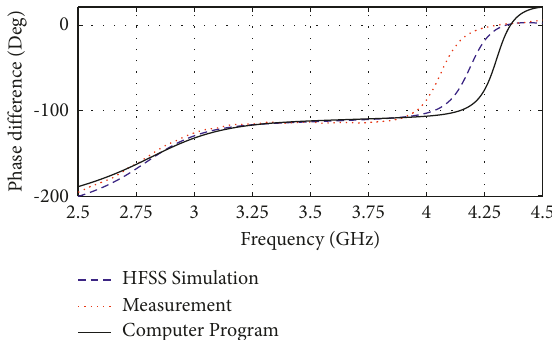
Figure 14: Phase difference between through and coupled ports of 6 dB ATRD